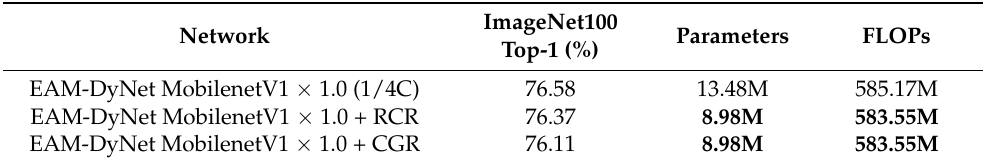
Table 5. The parameters and FLOPs of different channel selection methods on EAM-DyNet MobilenetV1.